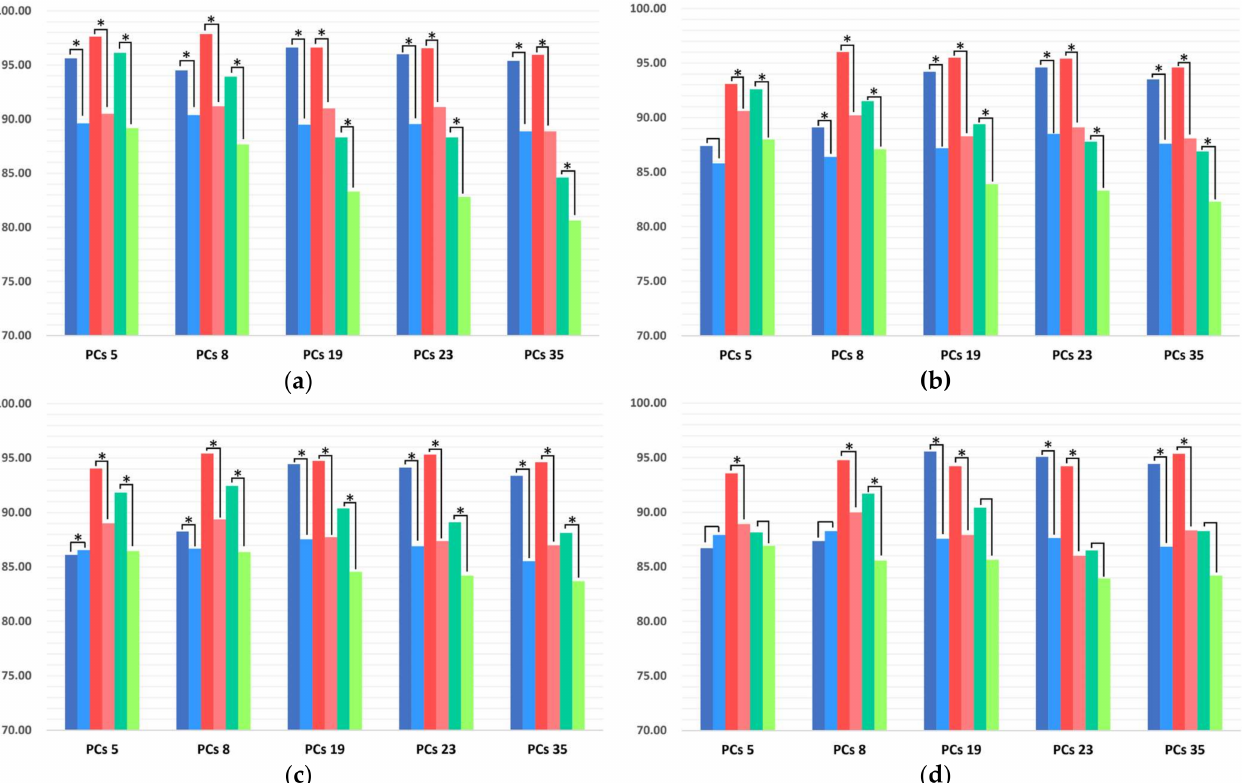
Figure 6. Total mean accuracy rates of GLs from four to seven using SVM, LDA, and k-NN, dependent on the application of PCA (* p < 0.05) on paretic (P19) and non-paretic (NP19) datasets: PCA- dependent GL4 ( a ), GL5 ( b ), GL6 ( c ), and GL7 ( d ) model. Legend options: dark blue (NP19) and blue (P19) bars are the Acc from SVM, red (NP19) and pale-red (P19) bars are the Acc from LDA, dark-green (NP19) and green (P19) bars are the Acc from k-NN. Asterisks between the paretic and non-paretic evaluations of the single classifier indicate statistical significance (* p <